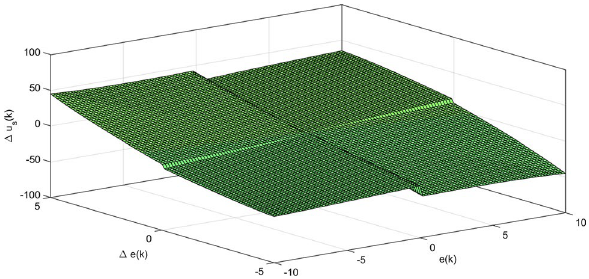
Fig. 9 Control surface plot in the reduced UoD [− L 1 , L 1 ] × [− L 2 , L 2 ] 0.5 with 𝜃 1 = 𝜃 2 =